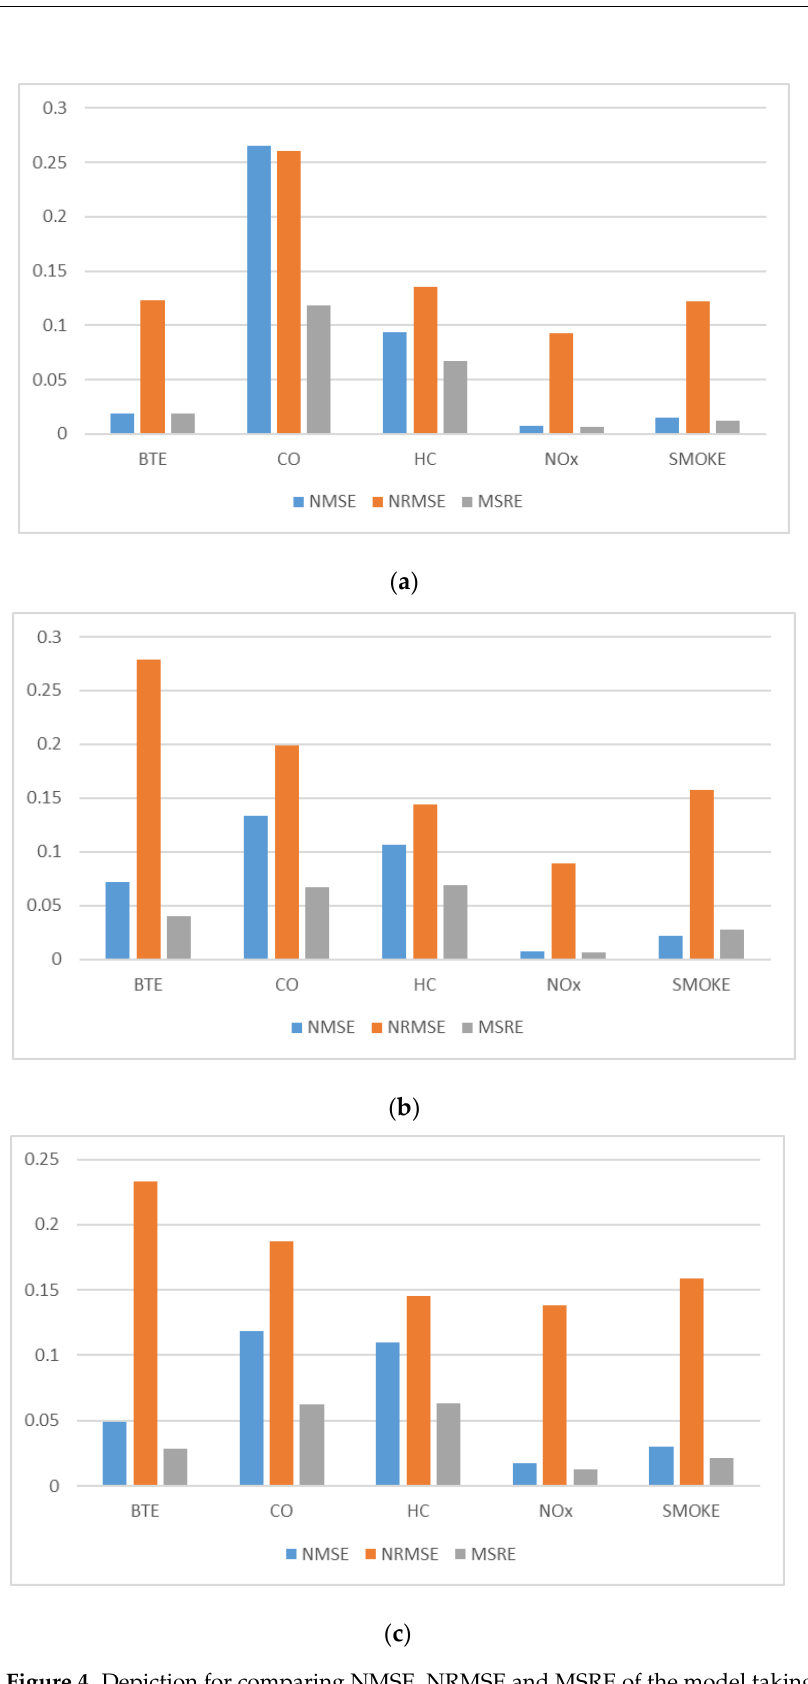
Figure 4. Depiction for comparing NMSE, NRMSE and MSRE of the model taking ( a ) 3 neurons; ( b ) 5 neurons; and ( c ) 7 neurons.